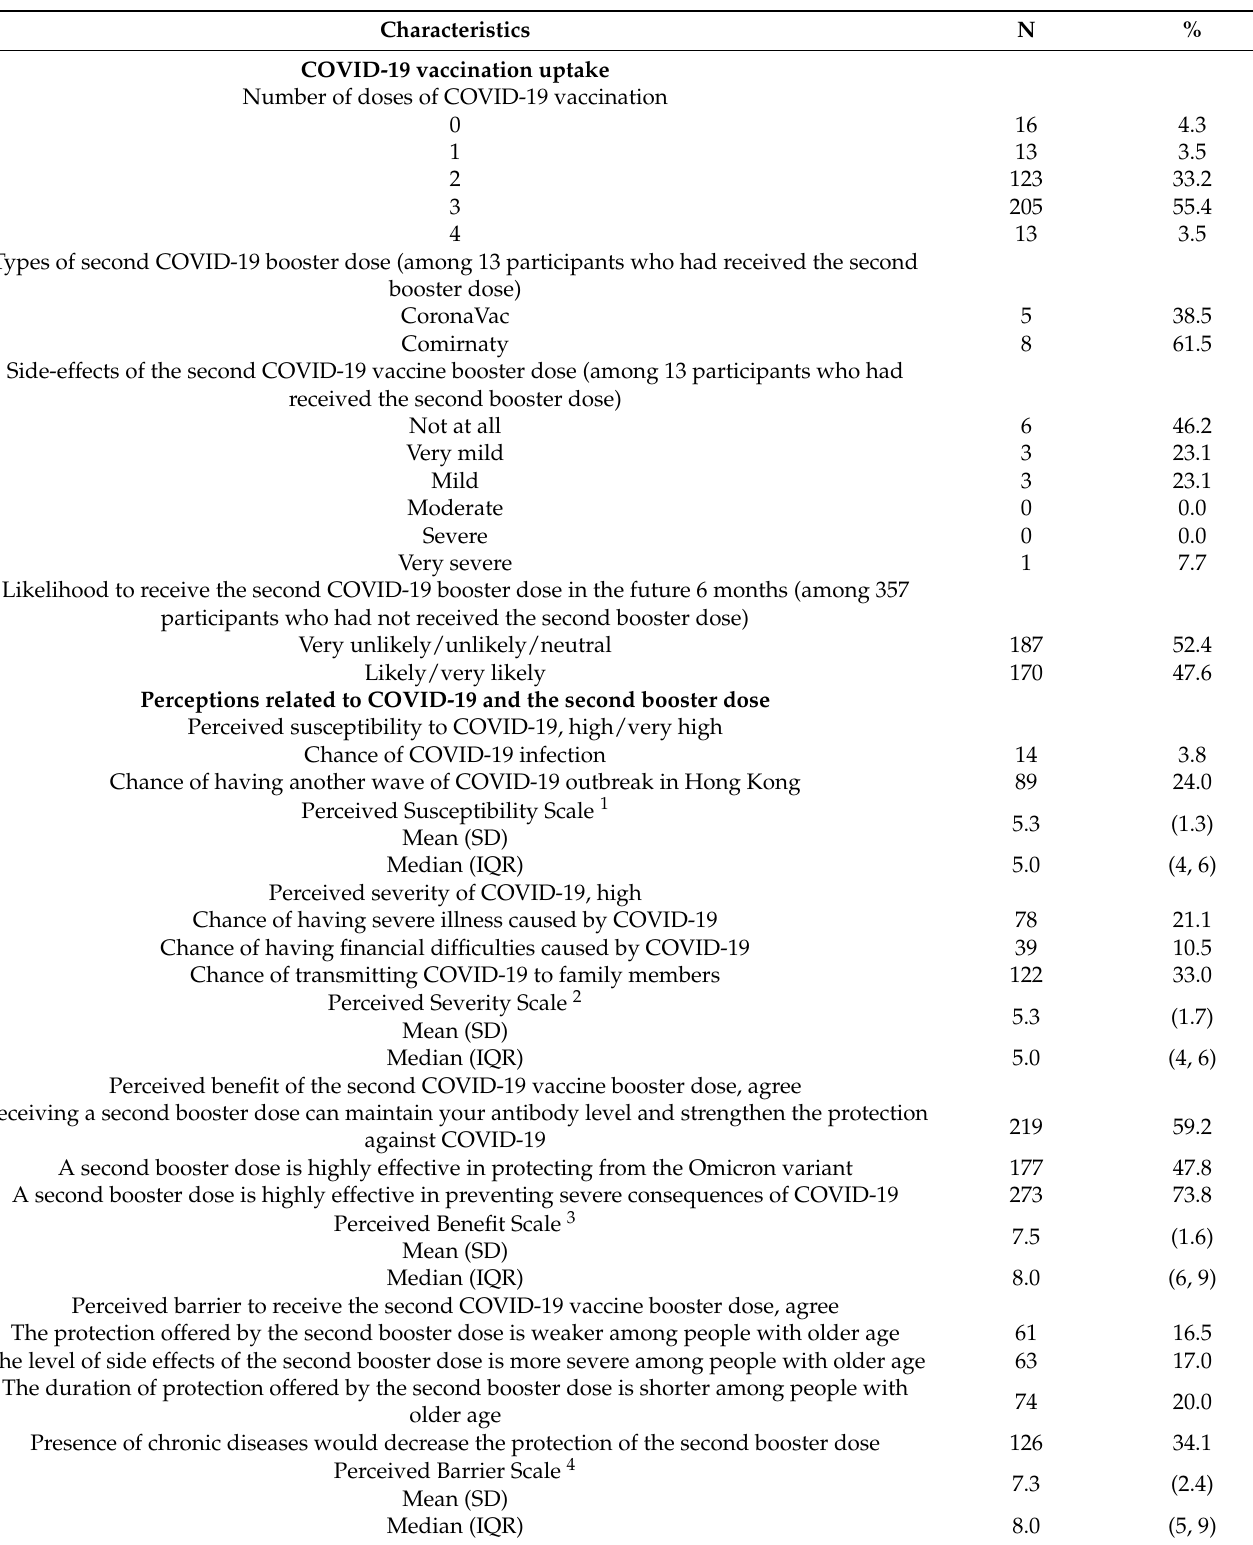
Table 2. Hesitancy and attitudes toward the second COVID-19 booster